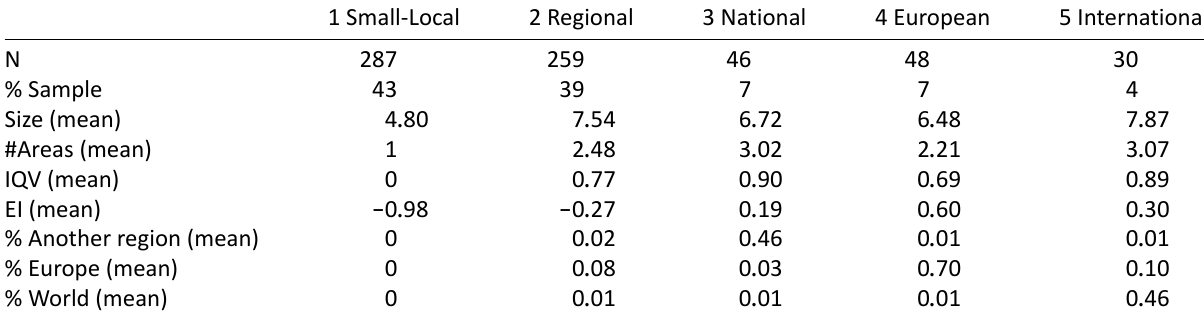
Table 2. Description of groups by the indices (MOSAiCH, N = 670).